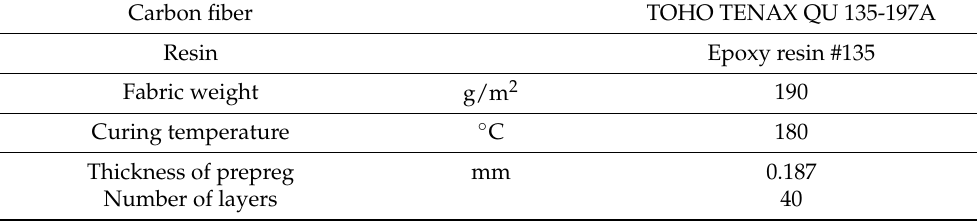
Table 3. Specifications of CFRP